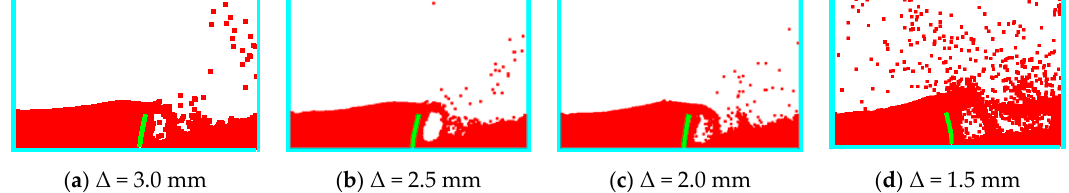
Figure 4. Simulated free surface and corresponding structure deformation using different particle spacings at t = 0.62 s.